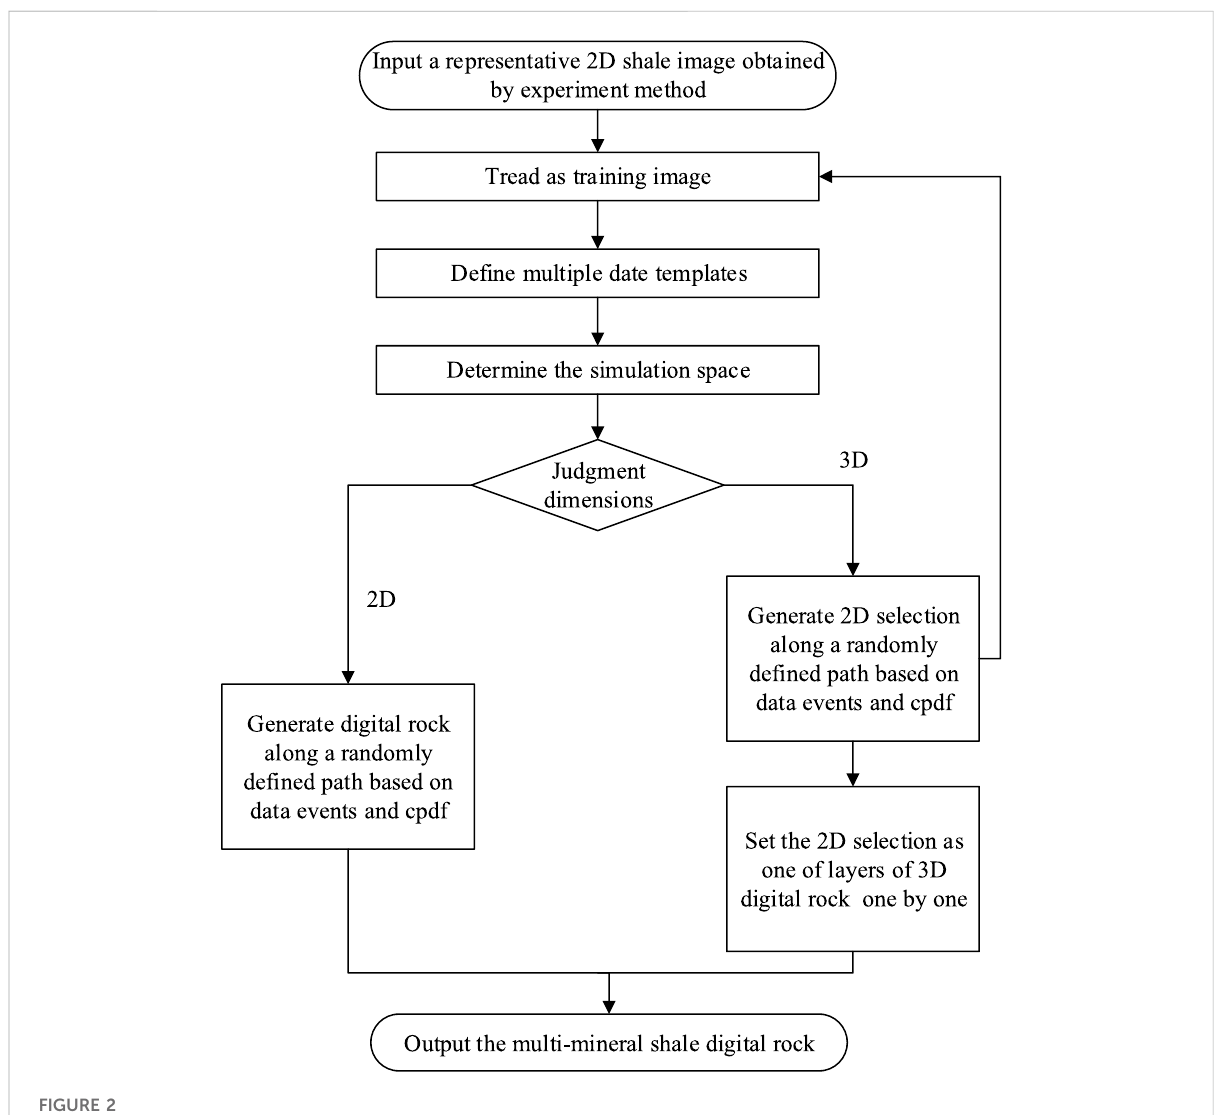
FIGURE 2 Flow chart of multi-mineral shale digital rock reconstruction using